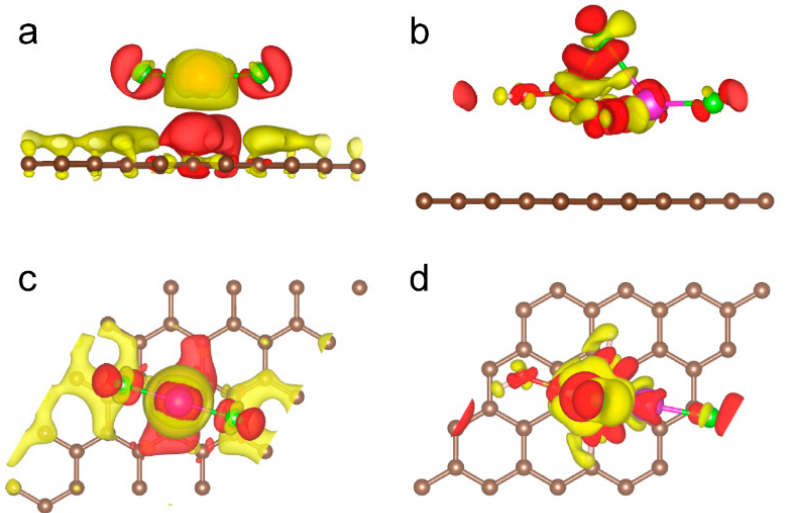
Figure 3. Charge density difference of the front views of CdCl 2 on G ( a ) and Fe@G ( b ), and the top views of CdCl 2 on G ( c ) and Fe@G ( d ). The isosurface is set to 3 × 10 − 4 e Å − 3 in CdCl 2 on G and set to 3 × 10 − 3 e Å − 3 in CdCl 2 on Fe@G. Note that yellow and red correspond to charge depletion and charge accumulation.